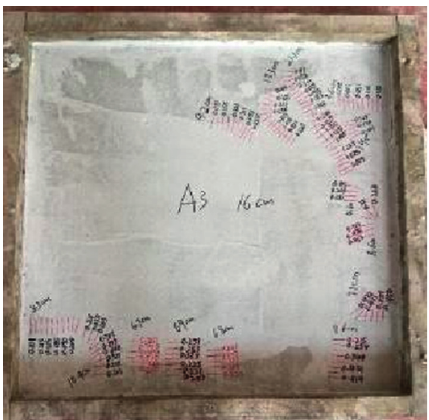
Figure 14: Test A3.